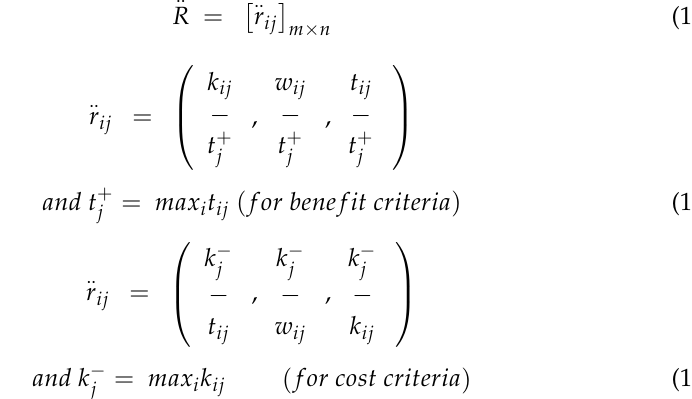
.. .. V ) by multiplying each r ij by